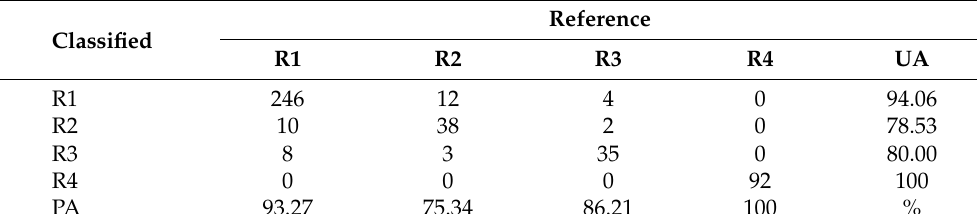
Table 5. Confusion matrices of the UFR classification on the study dataset. R1-R4 refer to residential, commercial, industrial and other UFRs. UA and PA refer to user accuracy and producer accuracy.